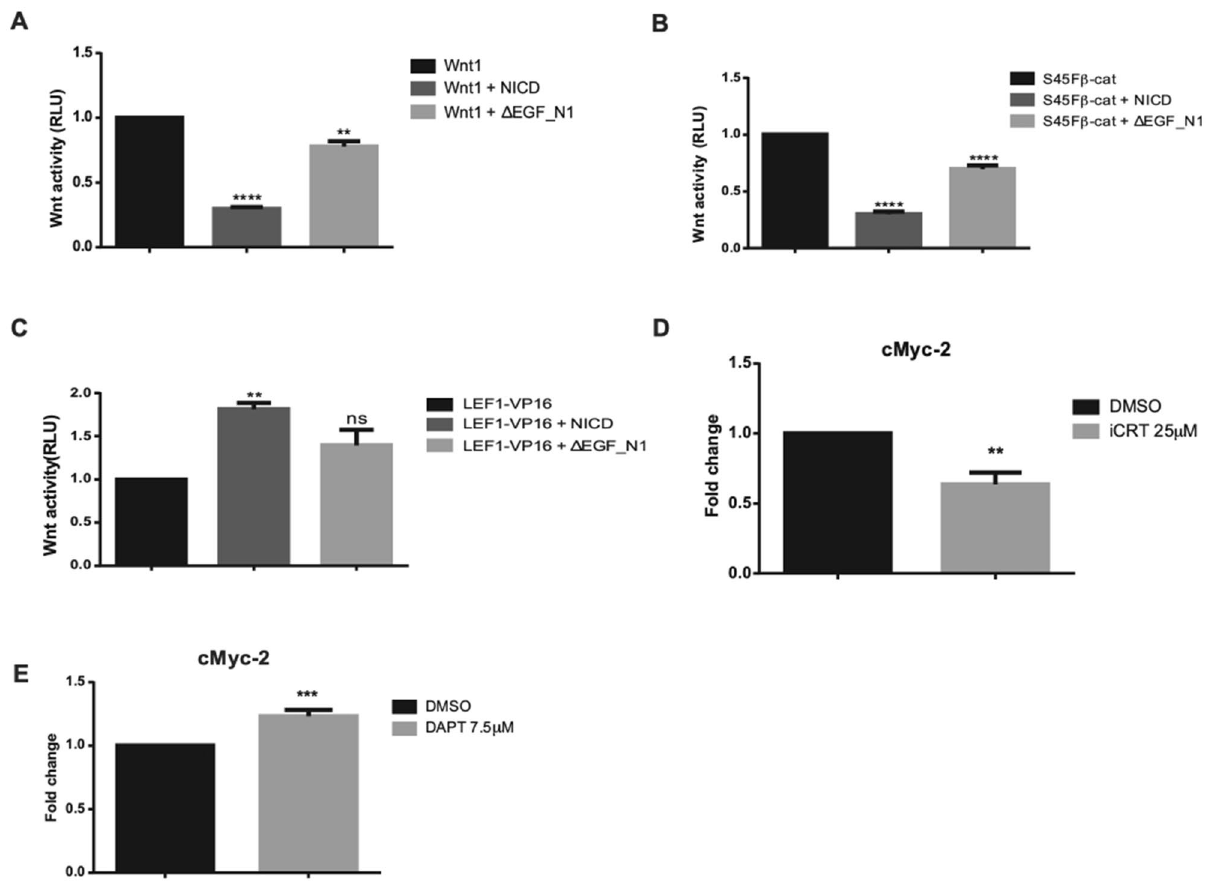
Figure 2. Both the ΔEGF_N1 and NICD protein can inhibit Wnt signalling. ( A , B ) ΔEGF_N1 and NICD inhibited Wnt1 and S45Fβ-catenin-driven Wnt signalling, whereas ( C ) neither could inhibit LEF1-VP16 induced transcription. HEK293T cells were transfected with Wnt reporter plasmid pTCFAdTATA ( A , B , C ) and Wnt signalling was activated by expressing Wnt1 ( A ), an active form of β-catenin (S45Fβ-catenin) ( B ), or LEF1-VP16 ( C ) alone or in the presence of the ΔEGF_N1 or NICD proteins as indicated. ( D , E ) Quantitative PCR (qPCR) analysis of c-Myc gene in HCT116 cells. As expected, c-Myc expression was reduced when Wnt signaling was blocked with the Wnt inhibitor iCRT ( D ). Inhibiting Notch signalling with DAPT treatment increased c-Myc expression, indicating endogenous Notch signalling is suppressing c-Myc expression ( E ). Luciferase assays were undertaken in HEK293T cells and were performed in triplicate. pRL-CMV was used as a transfection control and cells were lysed 48 h post transfection to determine luciferase activity. Data are presented as mean fold change (± SEM) in RLU or as mean fold change in gene expression (NS P > 0.05; ** P < 0.01, *** P < 0.001, **** P < 0.0001 one-way ANOVA and Tukey’s post-hoc test, N = Both NICD constructs were able to reduce S45Fβ-catenin induced transcription (Fig. 4C). Secondly, we co- expressed NICD with an increasing concentration of a dominant negative form of Hes5. Although expression of the dominant negative form of Hes5 can clearly disrupt the transcriptional repressor function of Hes5 (Fig. 4D), it did not alter the ability of NICD to inhibit S45Fβ-catenin induced transcription (Fig. 4E). Similarly, the expres- sion of the dominant negative form of Hey1 in increasing amounts did not alter the function of NICD to block S45Fβ-catenin induced transcription (Fig. S4D). Lastly, we expressed the NICD protein in cells where RBPj had been knockdown. This significantly reduced the ability of NICD to induce the expression of an RBPj-depend- ent reporter gene (Fig. 4F) and prevented the ability of NICD to inhibit S45Fβ-catenin induced transcription (Fig. 4G). Together these results indicate that NICD can inhibit Wnt signalling without inducing the expression of downstream target genes but requires RBPj. Notch interacts with β‑catenin to alter its function. To understand how NICD and ΔEGF-N1 inhibit S45Fβ-catenin-driven transcriptional activity, we first looked to see whether they promote the degradation of S45Fβ-catenin. As it is the soluble pool of β-catenin that is important for Wnt signalling, a cytosolic fractionation for S45Fβ-catenin, in the absence or presence of NICD and ΔEGF_N1, was performed. Expression of S45Fβ- catenin in HEK293T cells elevated the overall levels of endogenous β-catenin (lower band of the doublet, Fig. 5A) and showed accumulation of S45Fβ-catenin (upper band of the doublet, Fig. 5A) in the cytosol. Co-expression of NICD or ΔEGF-N1 had no discernible effect on the levels of endogenous β-catenin or S45Fβ-catenin.